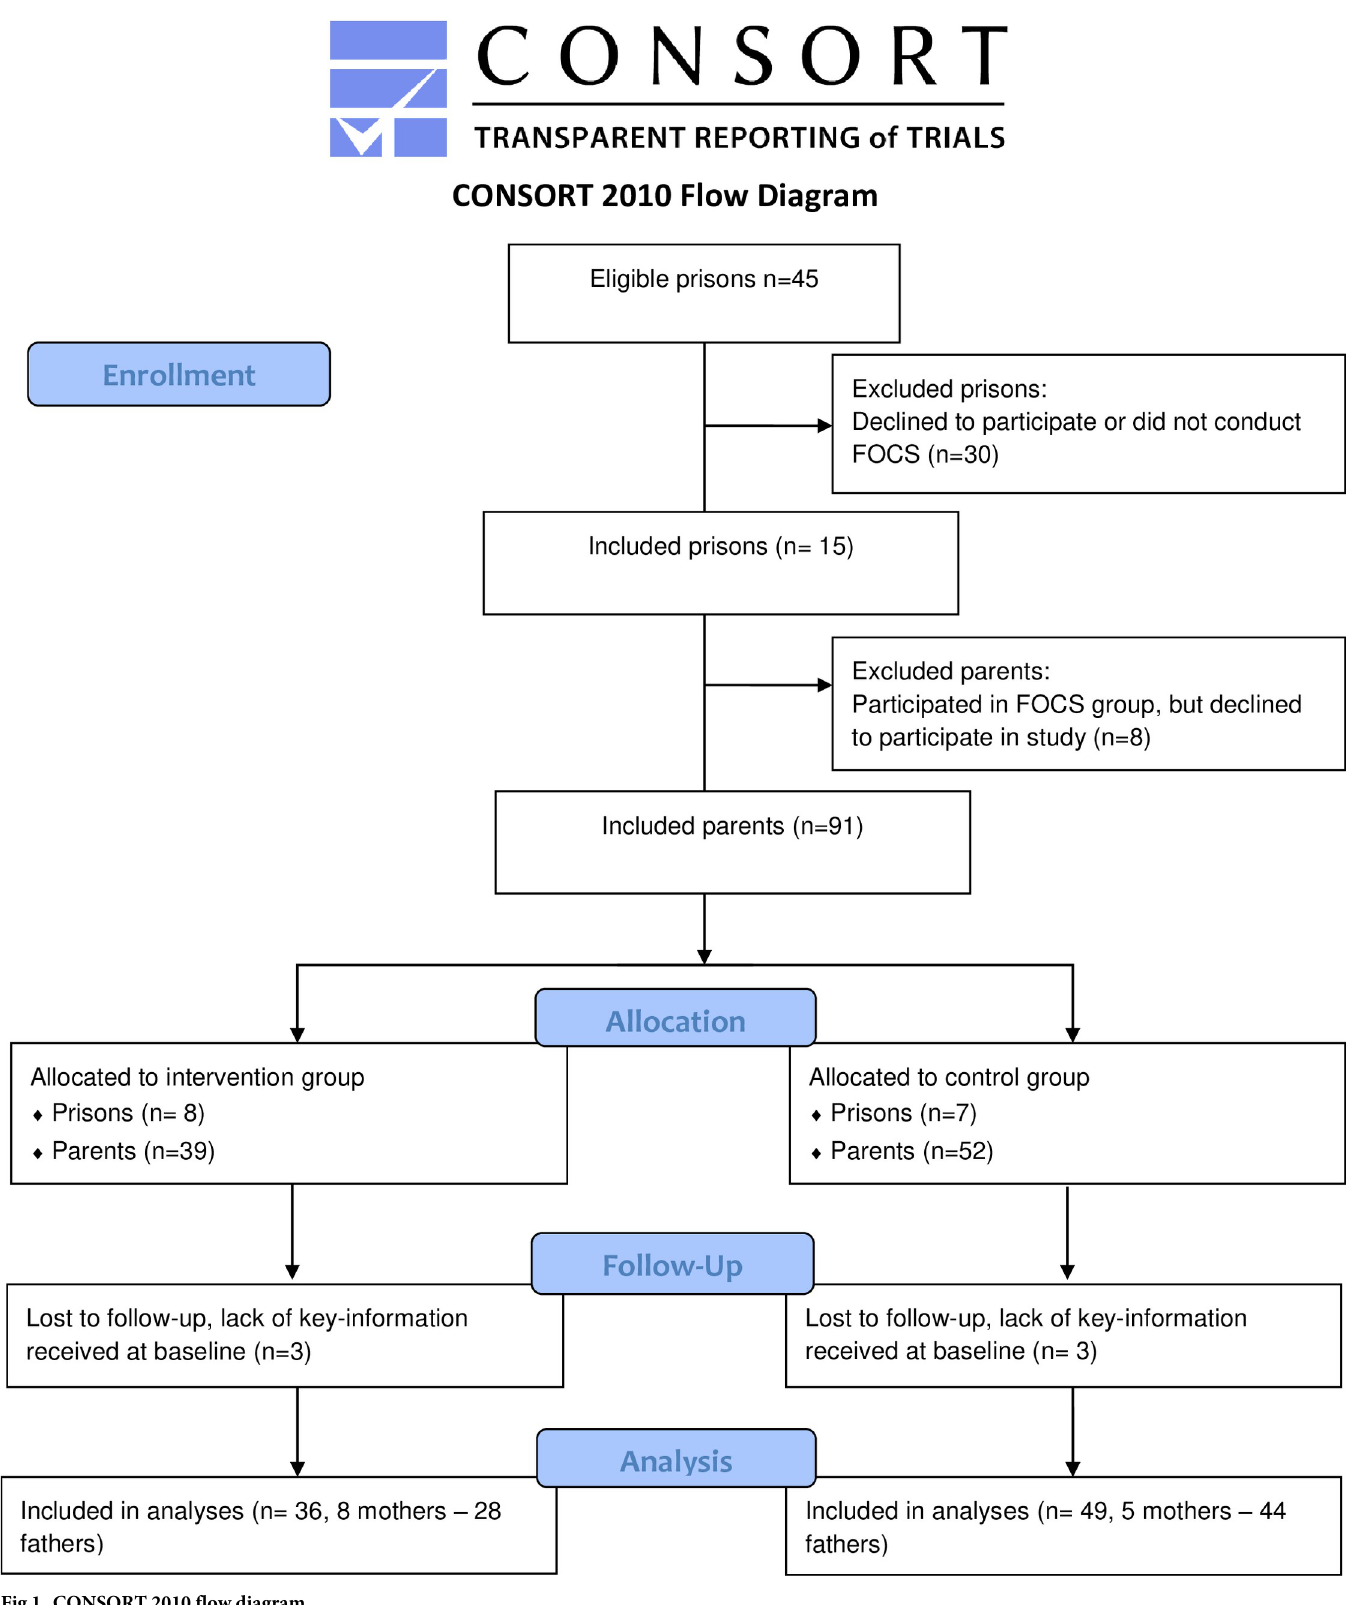
Fig 1. CONSORT 2010 flow diagram. https://doi.org/10.1371/journal.pone.0283177.g001 PLOS ONE | https://doi.org/10.1371/journal.pone.0283177 March 23,